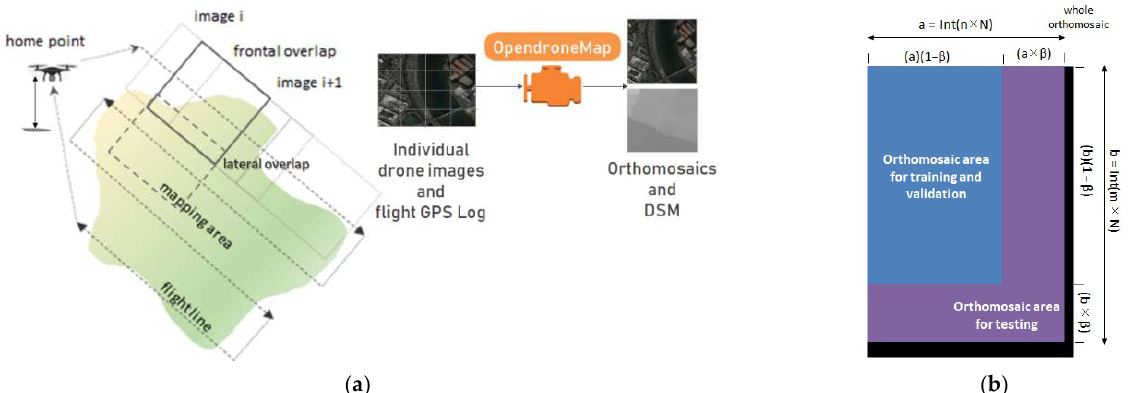
Figure 2. ( a ) Drone imagery workflow, ( b ) cropping area for training/validation and test datasets: “a” and “b” are the number of pixels horizontally and vertically, respectively, “n” is the number of images in every axis, and “ N ” is the tessellation size, for instance, 256 × 256 pixels. The black area is the residue of tessellation.